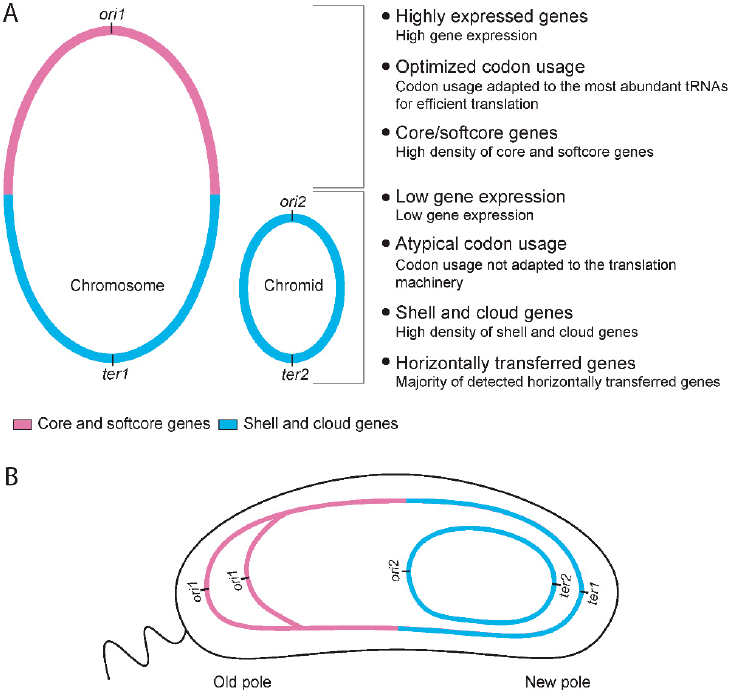
Figure 7. Summary of key characteristics of bipartite genomes in Vibrio and Pseudoalteromonas , and a putative model for accepted landing sites of HTGs. ( A ) Genes on the upper half of the chromosome are statistically more highly expressed, more likely to be core or softcore genes, and the codon usage is well adapted to the translational machinery. Genes located on the lower half of the chromosome, or the chromid, are statistically lower expressed, more likely to be shell or cloud genes, and have atypical codon usage less adapted to the translational machinery (compared to core/softcore). ( B ) Sketch of a hypothetical cell with a bipartite genome, and depicting the subcellular location of a chromosome and a chromid. The model is based on our pangenome calculations and genomic mapping of pangene types [32,35], and data from V. cholerae where the subcellular position of replicons have been determined [15,16,36,37]. Based on the genomic characteristics described in A, we hypothesize that chromids and the lower halves of the chromosomes are favored “landing sites” for gene acquisition in bipartite